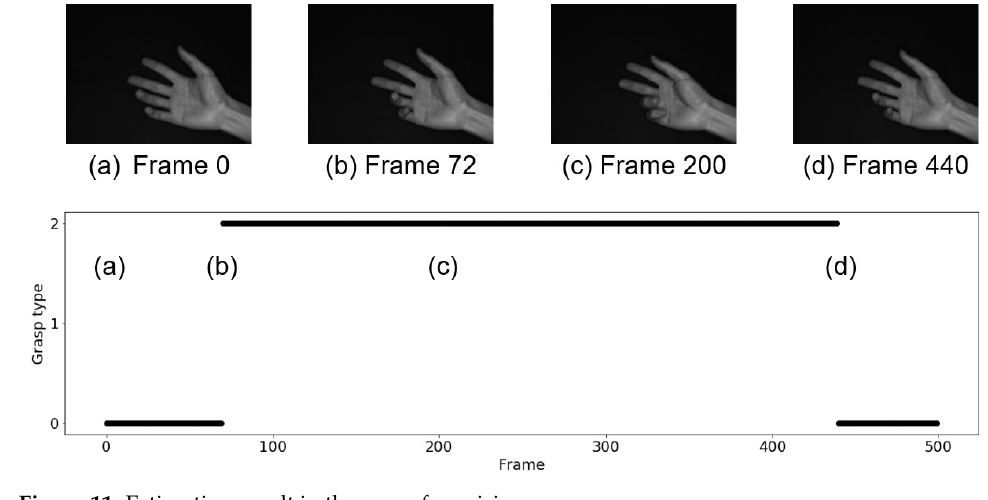
Figure 11. Estimation result in the case of precision grasp.